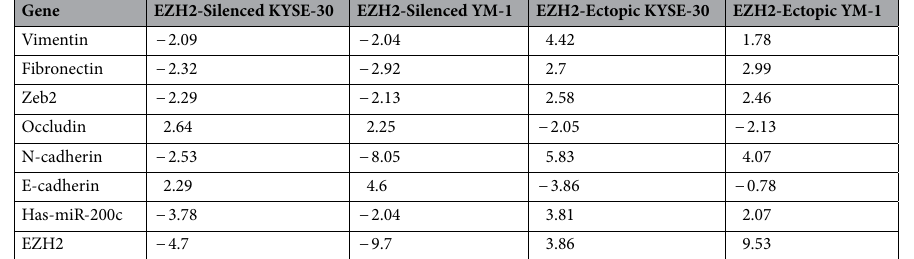
Table 2. Log2 fold change of genes assessed via quantitative real-time PCR.